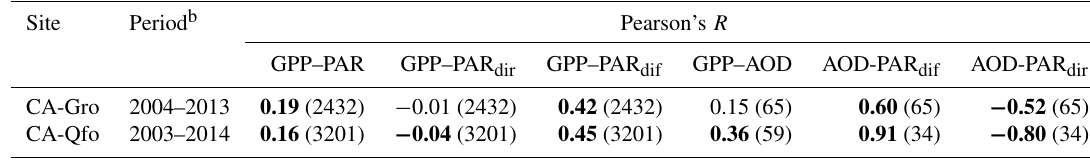
Table 4. Pearson’s correlation coefficients for GPP–PAR and GPP–AOD relationships at AmeriFlux (AMF) sites a .